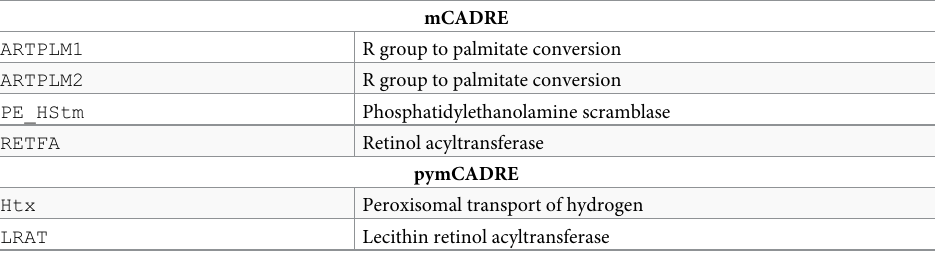
Table 2. Symmetric difference of reactions in the models created by mCADRE and